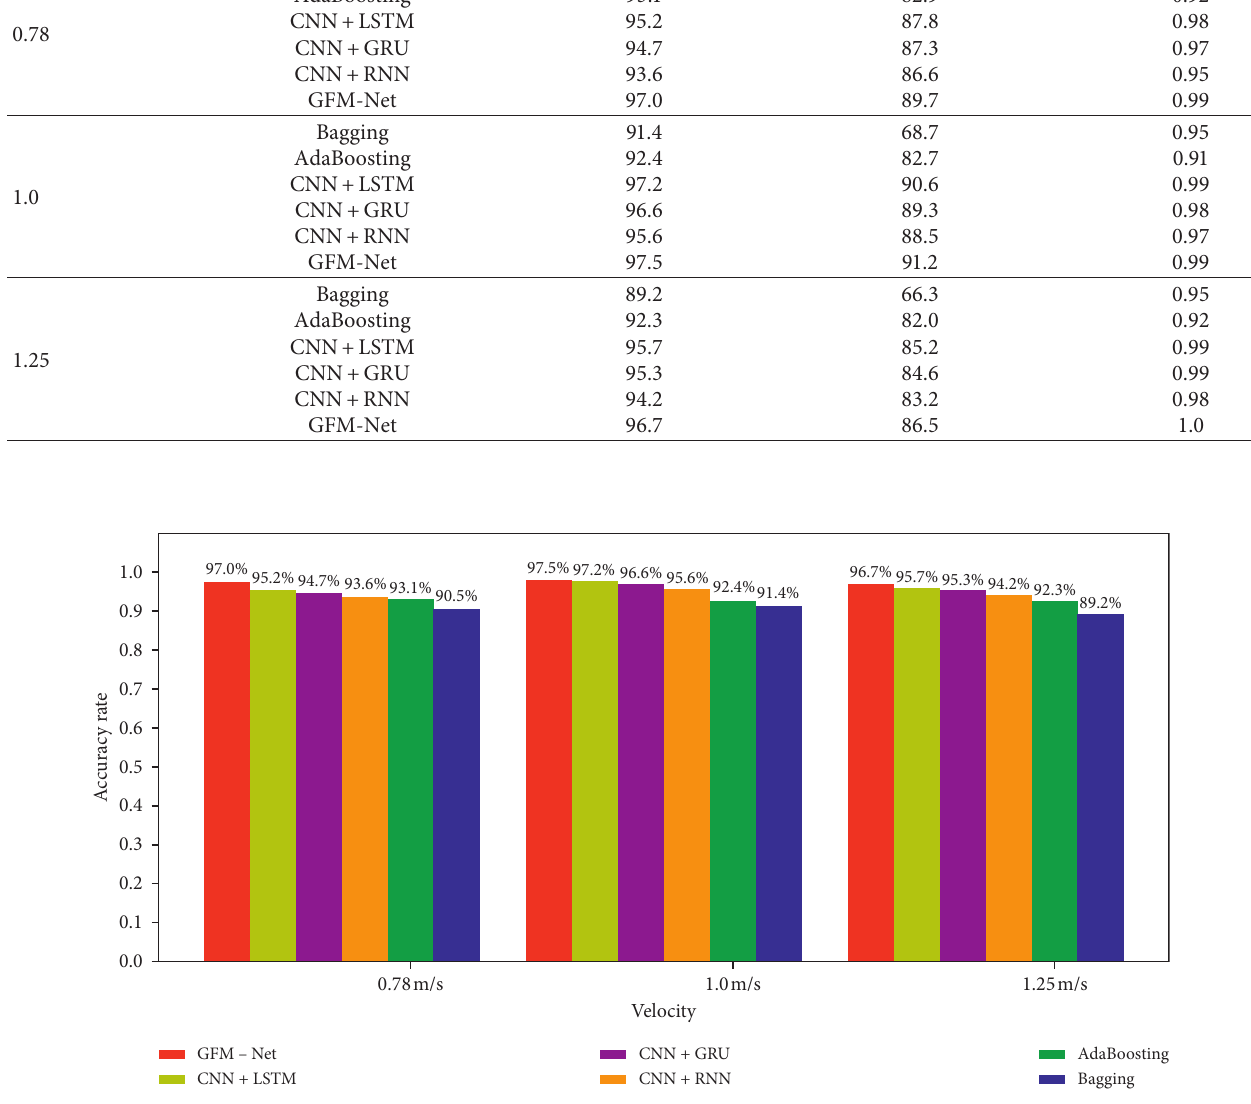
Figure 10: More tag set classifier accuracy distribution at three